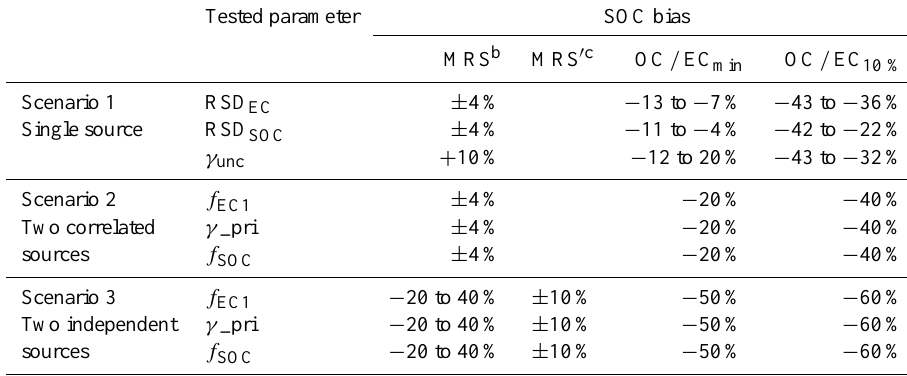
Table 3. Summary of numerical study results under different scenarios a . Tested parameter